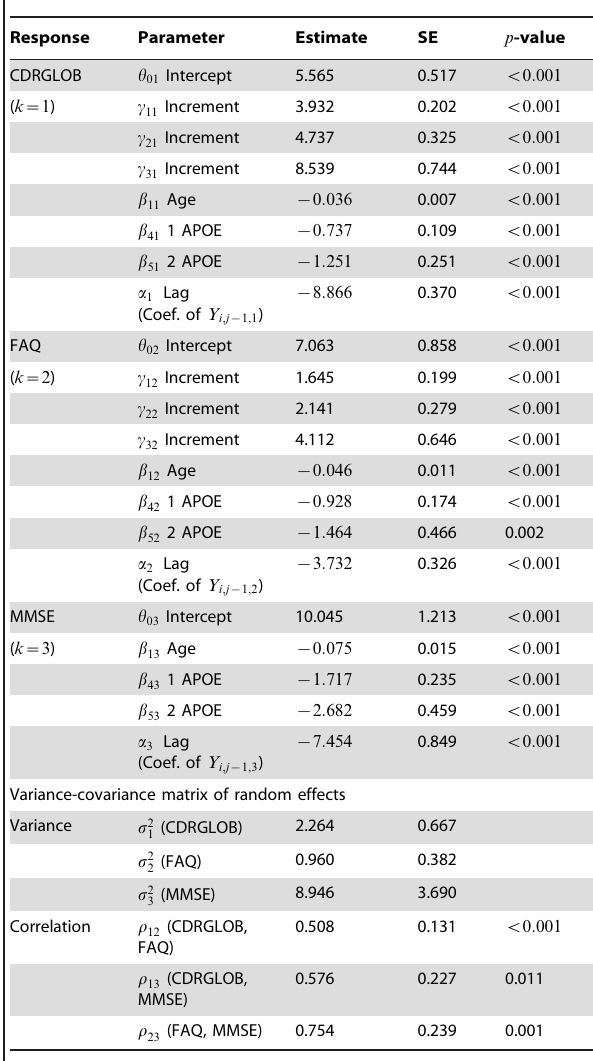
Table 2. Analysis results of the Uniform Data Set in the National Alzheimer’s Coordinating Center (three measurements): parameter estimates, sandwich estimators of variance (standard deviations) and covariance, and the p - values of Wald